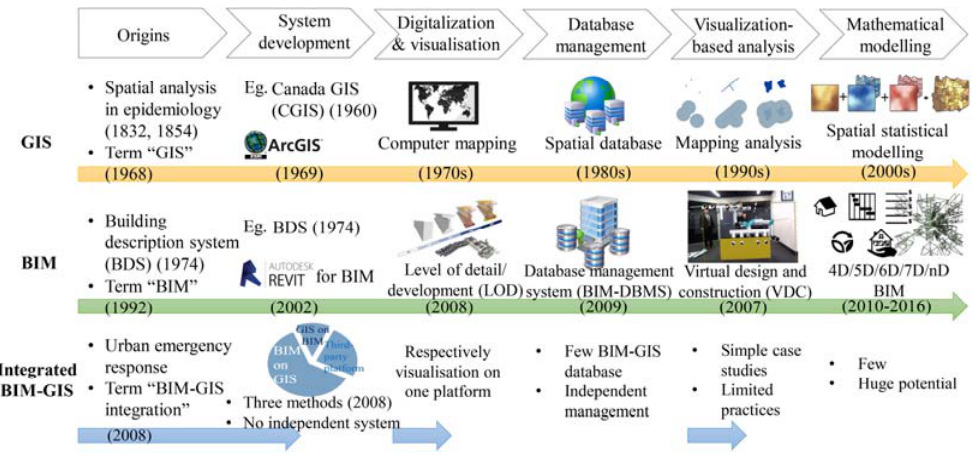
Figure 3. Comparison of evolution progresses of GIS, BIM and integrated BIM-GIS.